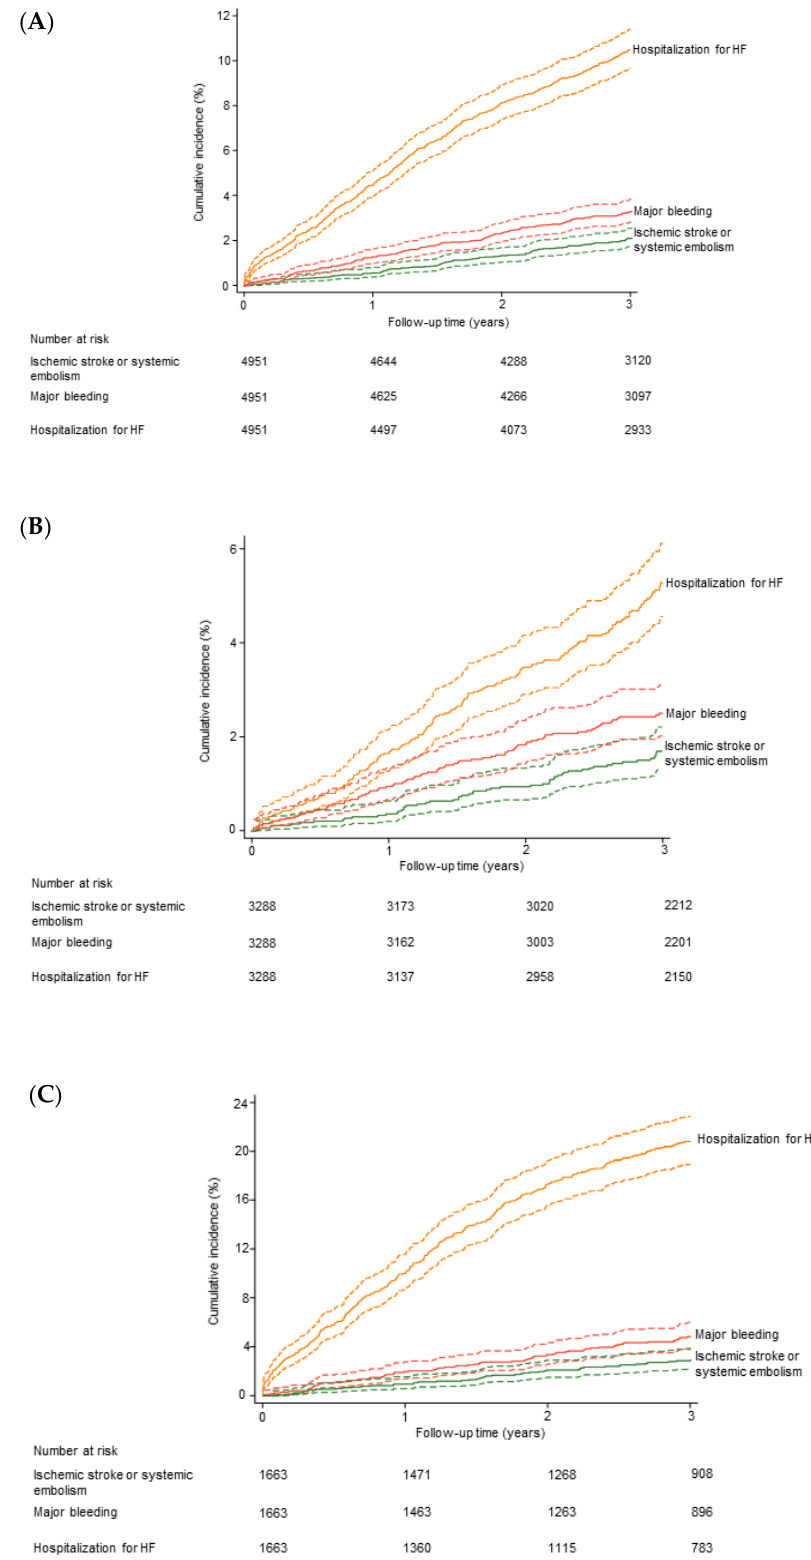
Figure 1. Incident events during follow-up. Cumulative incidence functions (death as the competing event) are shown. ( A ) Overall study population ( n = 4951 with follow-up). ( B ) Patients without HF at inclusion ( n = 3288 with follow-up). ( C ) Patients with HF at inclusion ( n = 1663 with follow-up). HF, heart